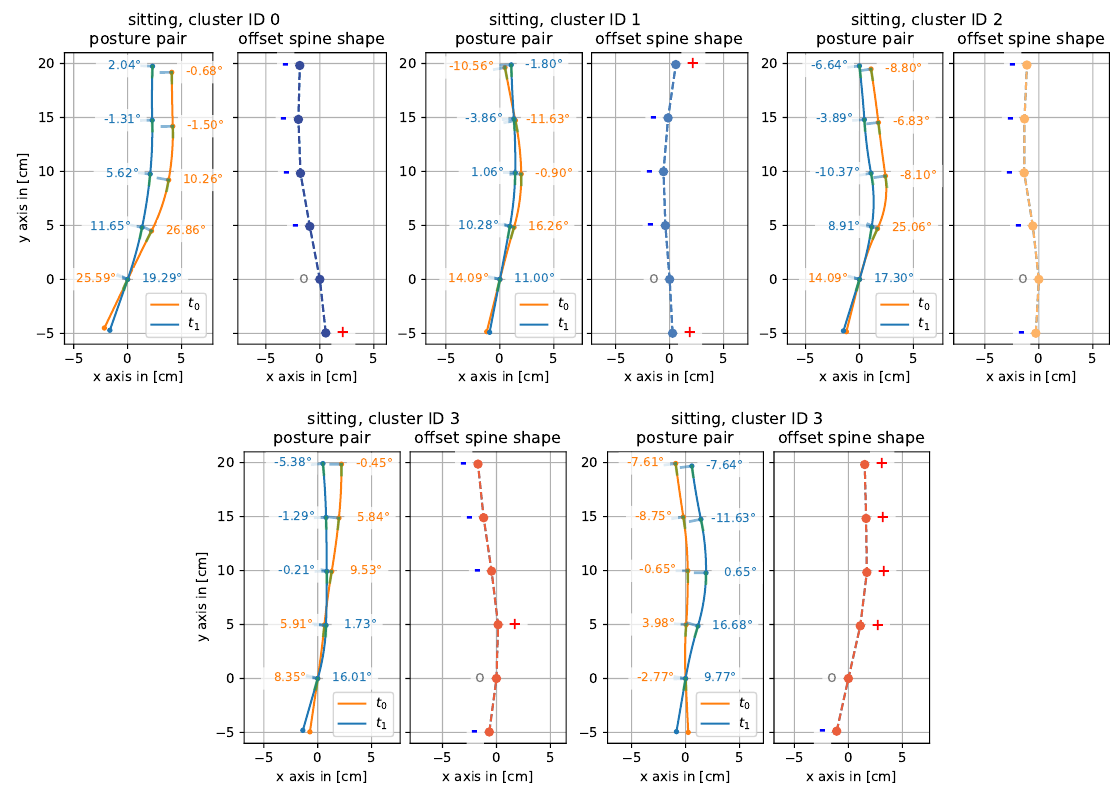
Figure A4. Results for clustering posture pairs of sitting : Cluster representative sample posture pairs and offset spine shapes for each cluster. Each sample’s position within its cluster is marked by an ‘x’ in the colored t-SNE map.